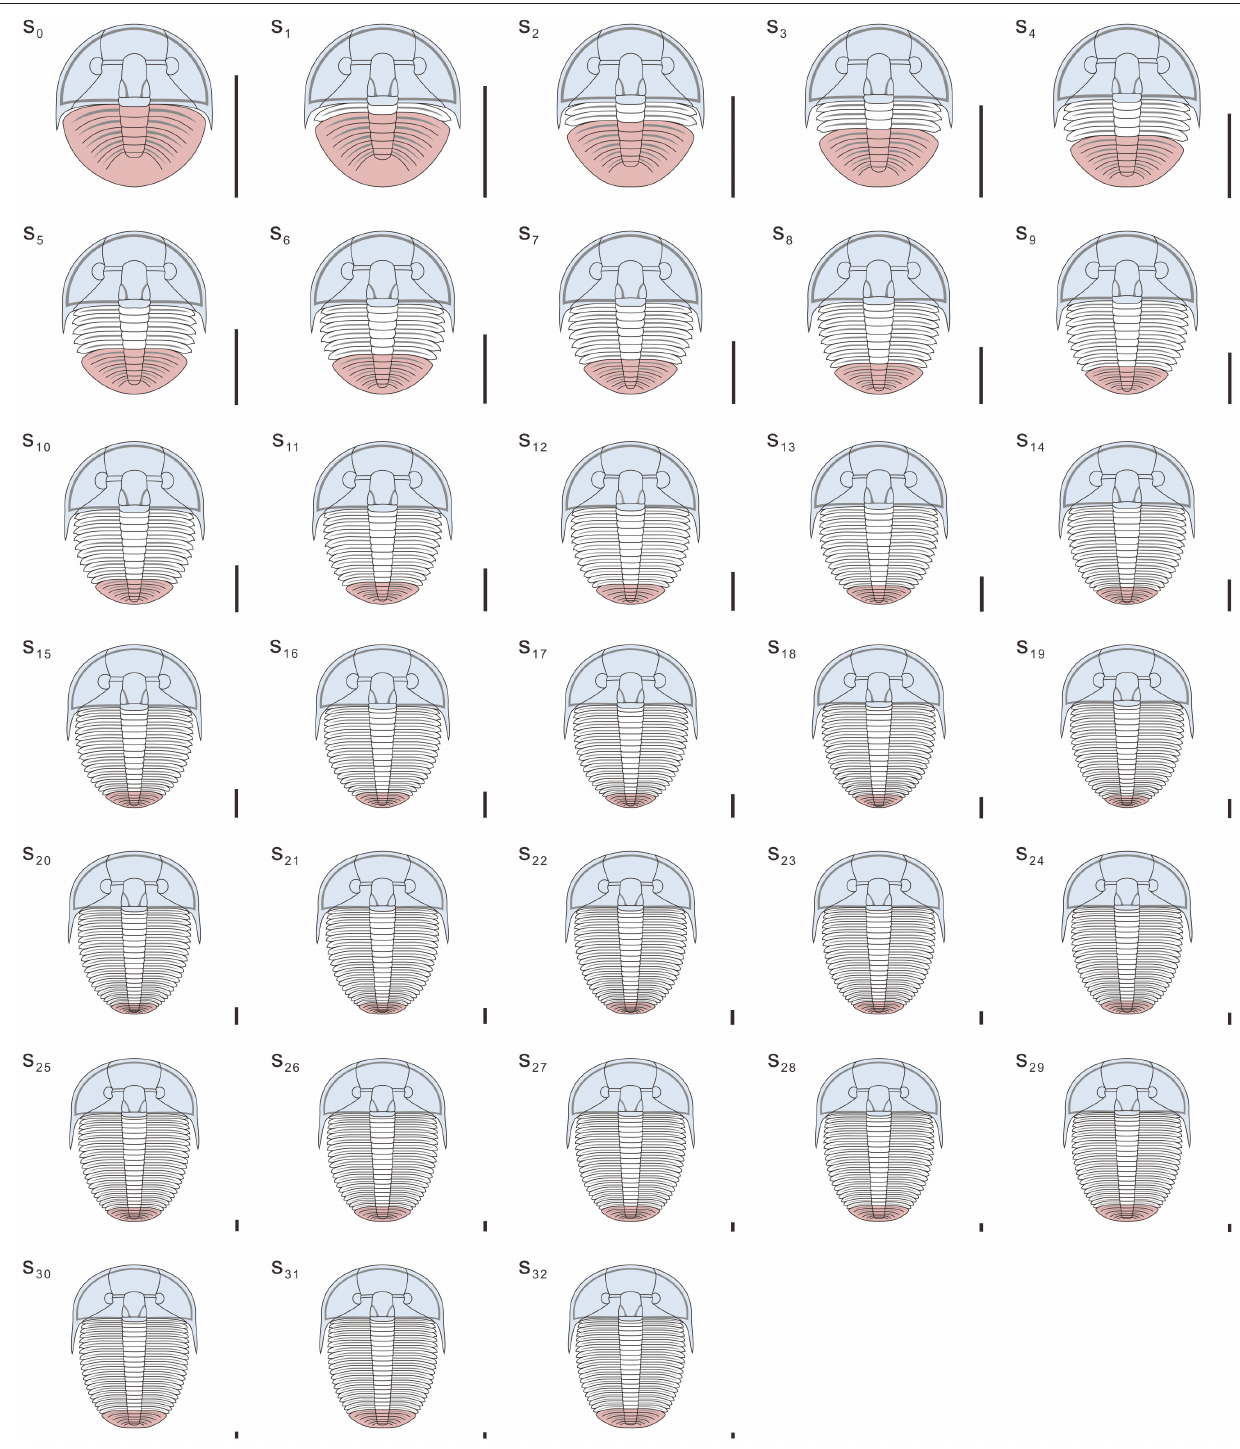
Frontiers in Ecology and Evolution |